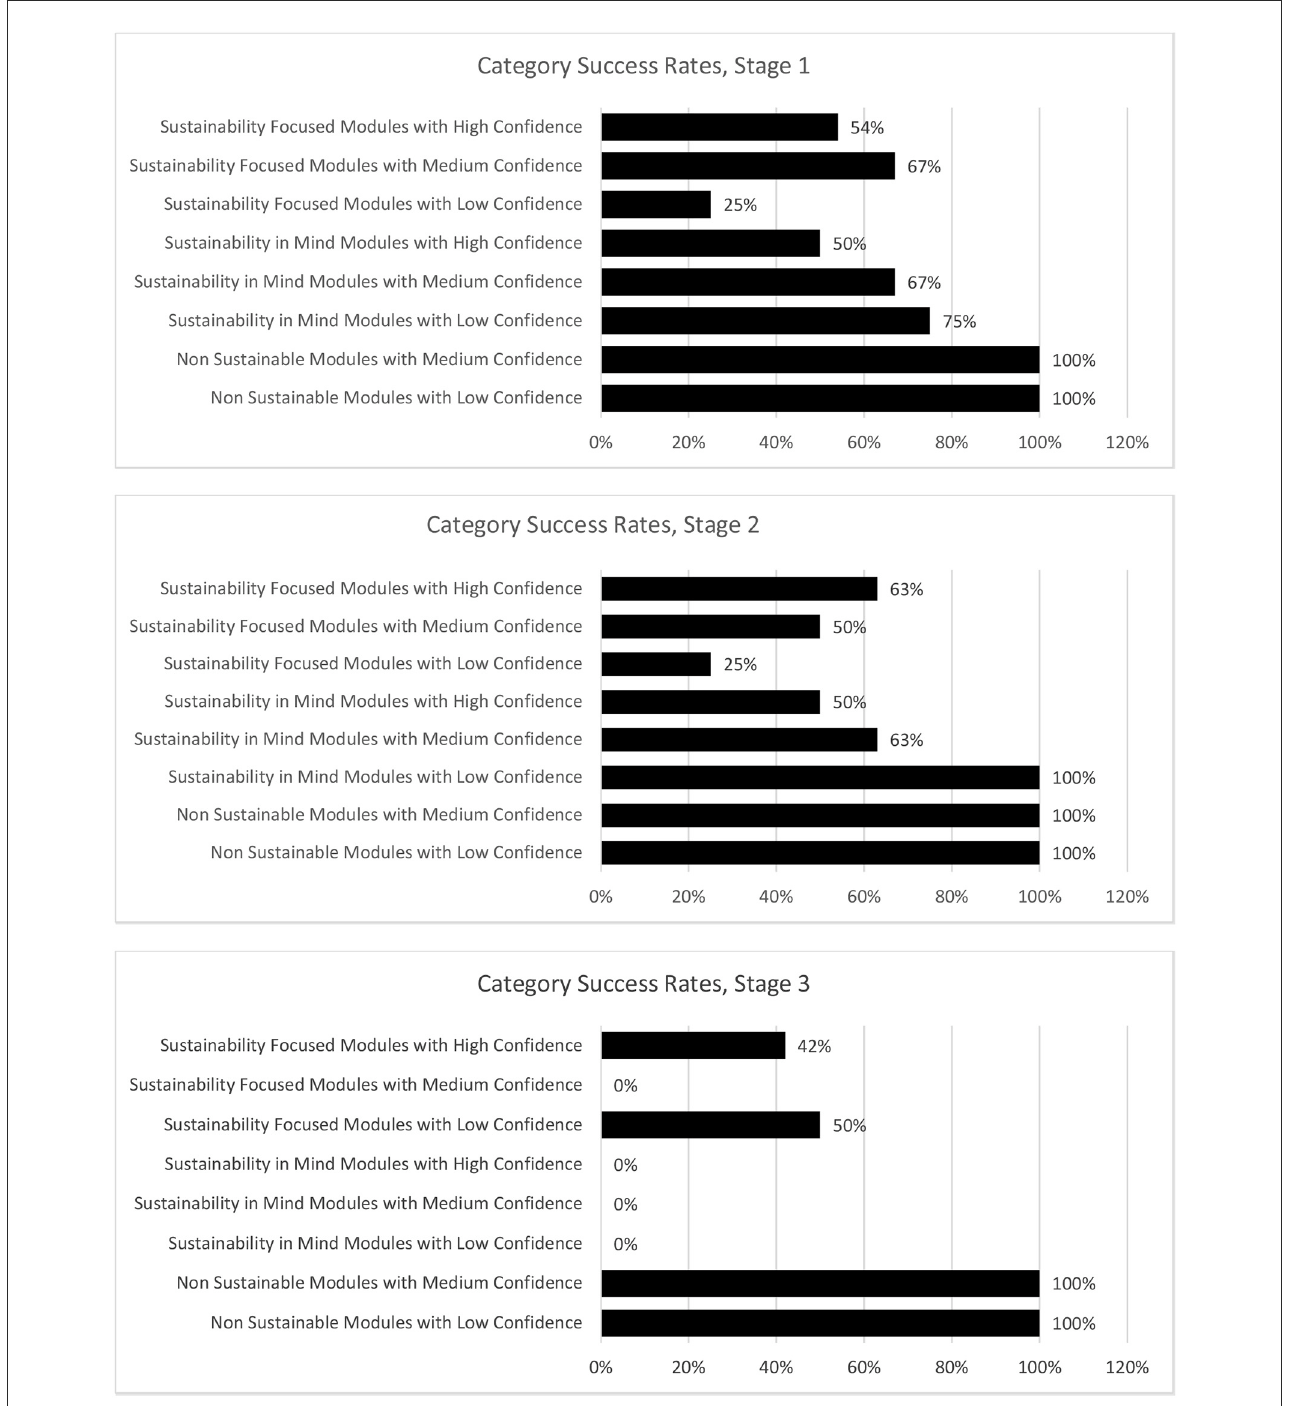
FIGURE6 Overall AASHE-STARS Category Success Rate for each of the three stages of the manual